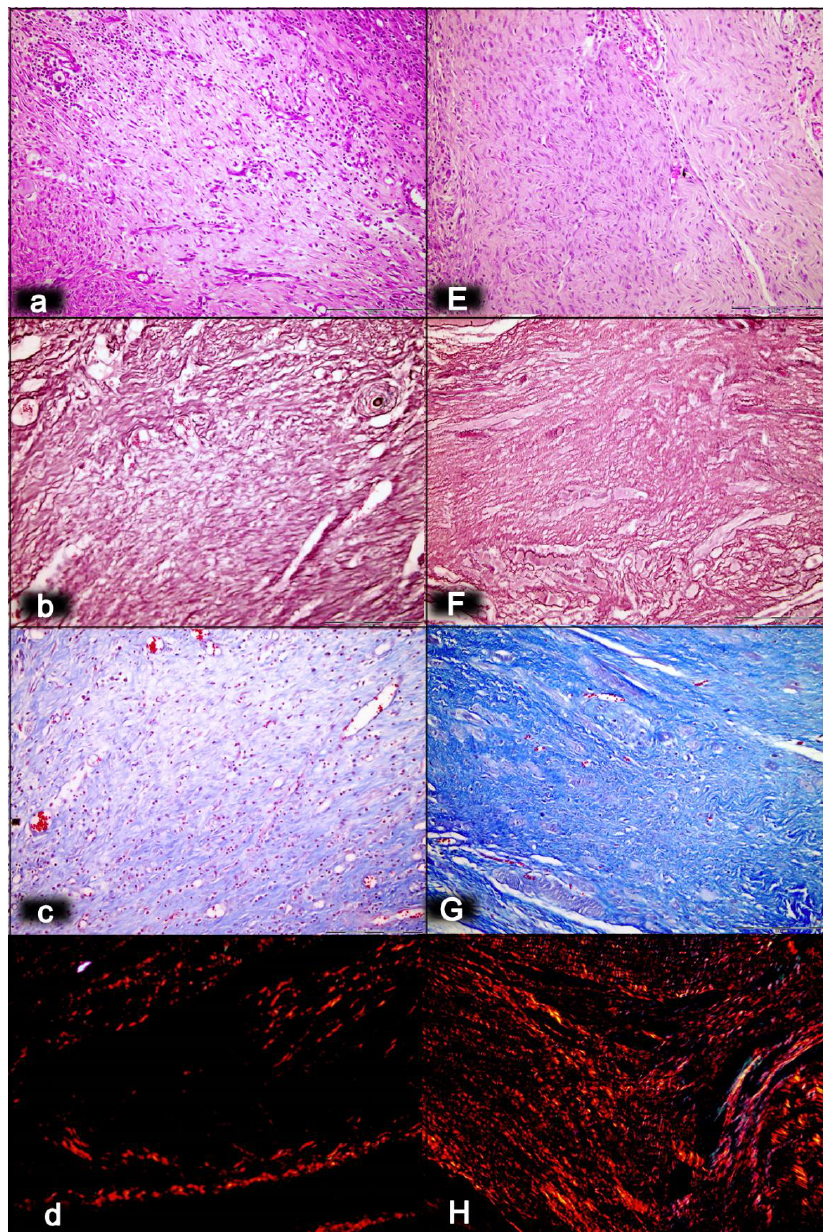
Figure 2. Myotendinous junction 14 days following dissection of quadriceps tendon from the quadriceps muscle [43]. Regular presentation after myotendinous junction injury induction in control rats (small letters) ( a – d ). Persistent edema and marked infiltration of inflammatory cells with mild and delayed increase of vascularity of myotendinous junction ( a ). A discrete fibroblast proliferation and reticulin ( b ) and collagen fibers ( c ) production producing a connective tissue with mesh-like fibers and areolar tissue. Regular presentation after myotendinous junction injury during BPC 157 regimen (capitals), given in drinking water ( E – H ). No edema and inflammatory cells with well orientated dense connective tissue. Complete vanishing of myotendinous junction revascularization ( E ). Prominent fibroblast proliferation with reticulin ( F ), and collagen fibers synthesis with good orientation and maturation was found ( G ). Using a polarized microscope, sparse and disorganized collagen type 1 fibers were observed in the control ( d ). In treated animals, the appearance of abundant and well-oriented collagen type 1 fibers was found ( H ). HE staining ( a , E ); histochemical Gomori staining ( b , F ) and Masson trichrome staining ( c , G ); Sirius red histochemical staining with polarized microscopy ( d , H ); magnification ×